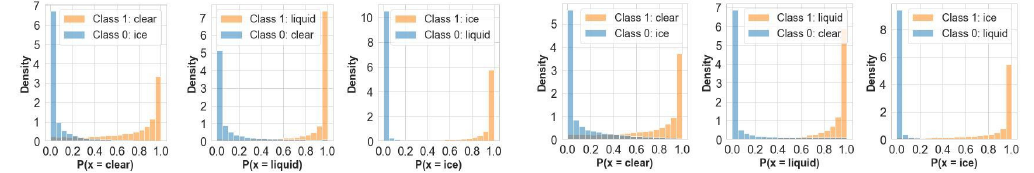
Figure 9. As in Figure 8 but for the synthetic AMSU-A/MHS validation dataset.